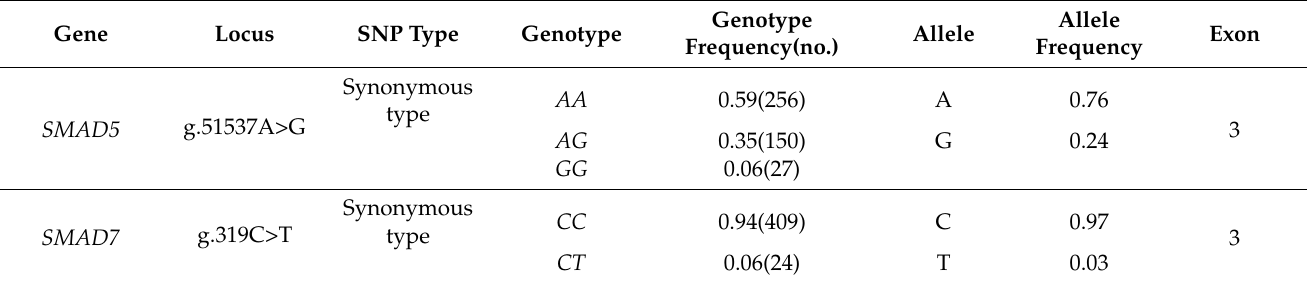
Table 2. In Tibetan sheep, the genotype and allele frequencies of single nucleotide polymorphism loci of SMAD5 and SMAD7 .